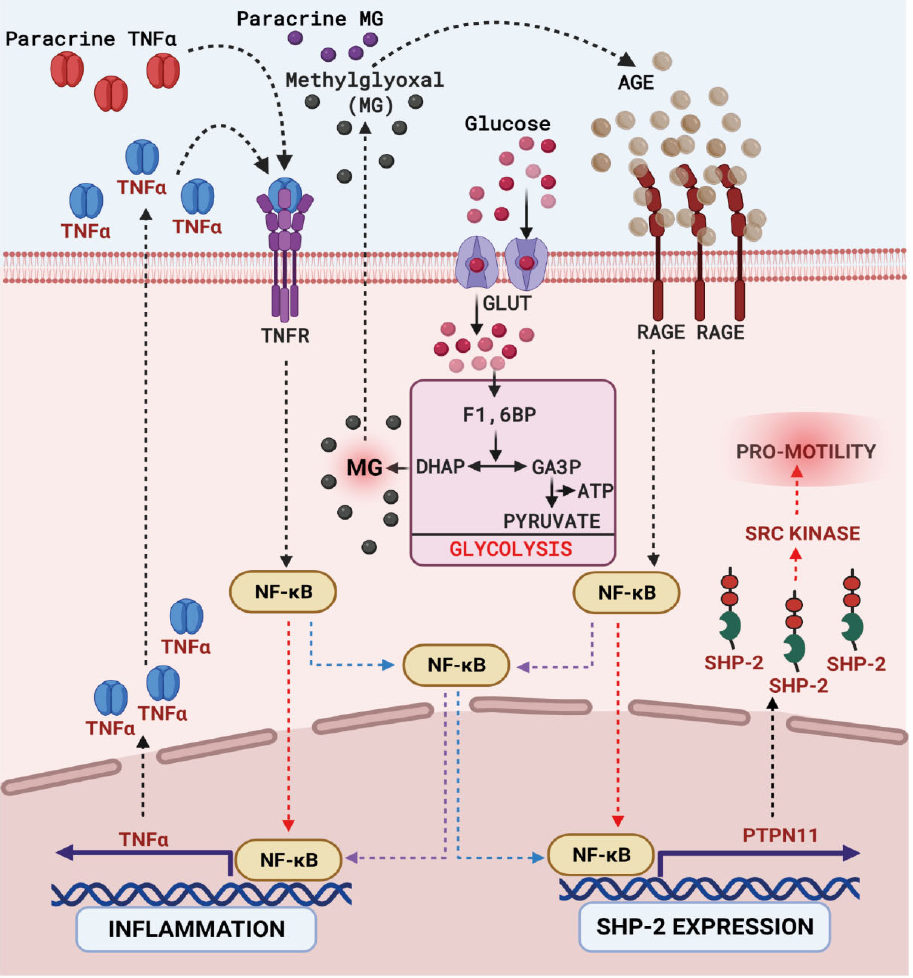
Figure 6. Model depicting the role of RAGE-NFkB signalling axis in regulating SHP-2 expression in hyperglycemic monocytes. In T2DM patients, enhanced intracellular glucose transport leads to an elevated glycolysis rate. This results in the accumulation of a highly reactive glucose metabolite, methylglyoxal (MG). MG leads to the formation of advanced glycated end products (AGEs), which can bind to the Receptor for AGEs (RAGE) on the cell surface of monocytes. MG generated in a paracrine manner could also induce the RAGE signalling. Upon the induction of RAGE signalling, transcription factor NFkB gets activated and translocated into the cell nucleus. There, it binds to the promoter of SHP-2, provoking the enhanced transcription of the tyrosine phosphatase. Simultaneously, the RAGE-induced NF κ B promotes the production of TNF α . TNF α stimulates the TNF α receptor (TNFR) on the surface of monocytes in an autocrine or paracrine fashion. Activation of TNF signalling accelerates nuclear NF κ B accumulation, leading to SHP-2 expression upregulation. Both these events are mutually exclusive. Subsequently, the elevated expression of SHP-2 induces monocyte activation by provoking a pro-migratory phenotype in Figure S3: Dual inhibition of NF κ B attenuates MG ‐ , AGE ‐ mimetic ‐ and TNF α‐ induced SHP ‐ 2 ex ‐ pression; Figure S4: MG ‐ induced SHP ‐ 2 expression is driven by NF κ B but it does not contribute to MG ‐ induced inflammation induction; Figure S5: Expression of RAGE in monocytes and its splice variants; Figure S6: The RAGE ‐ NF κ B axis controls SHP ‐ 2 expression activity; Table S1: Clinical